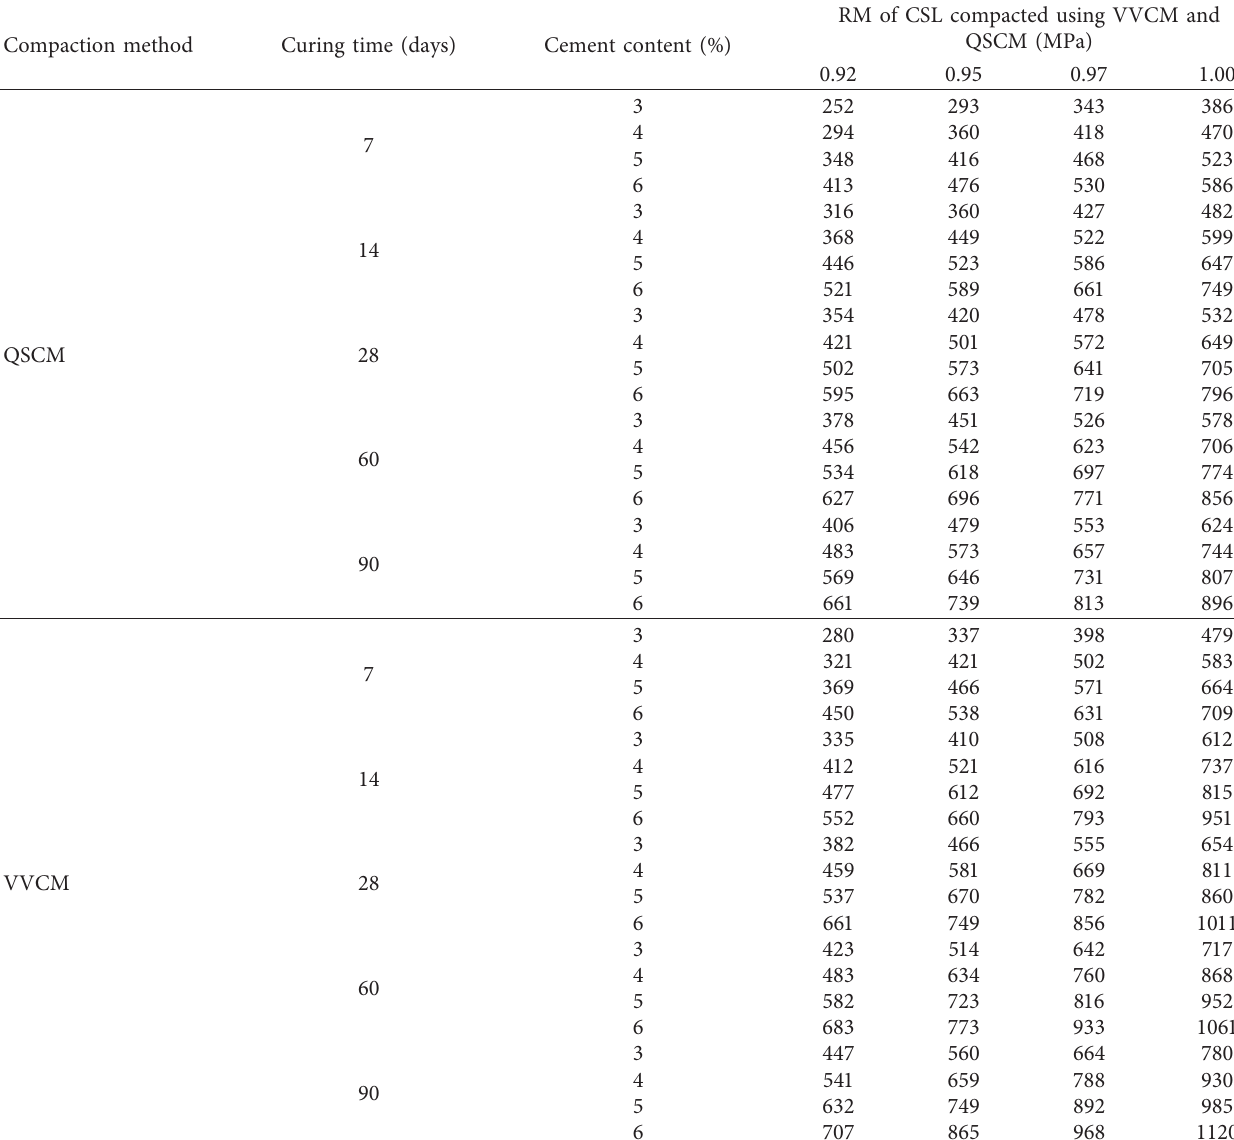
Table 10: Resilient modulus of CSL compacted using VVCM and QSCM. Compaction